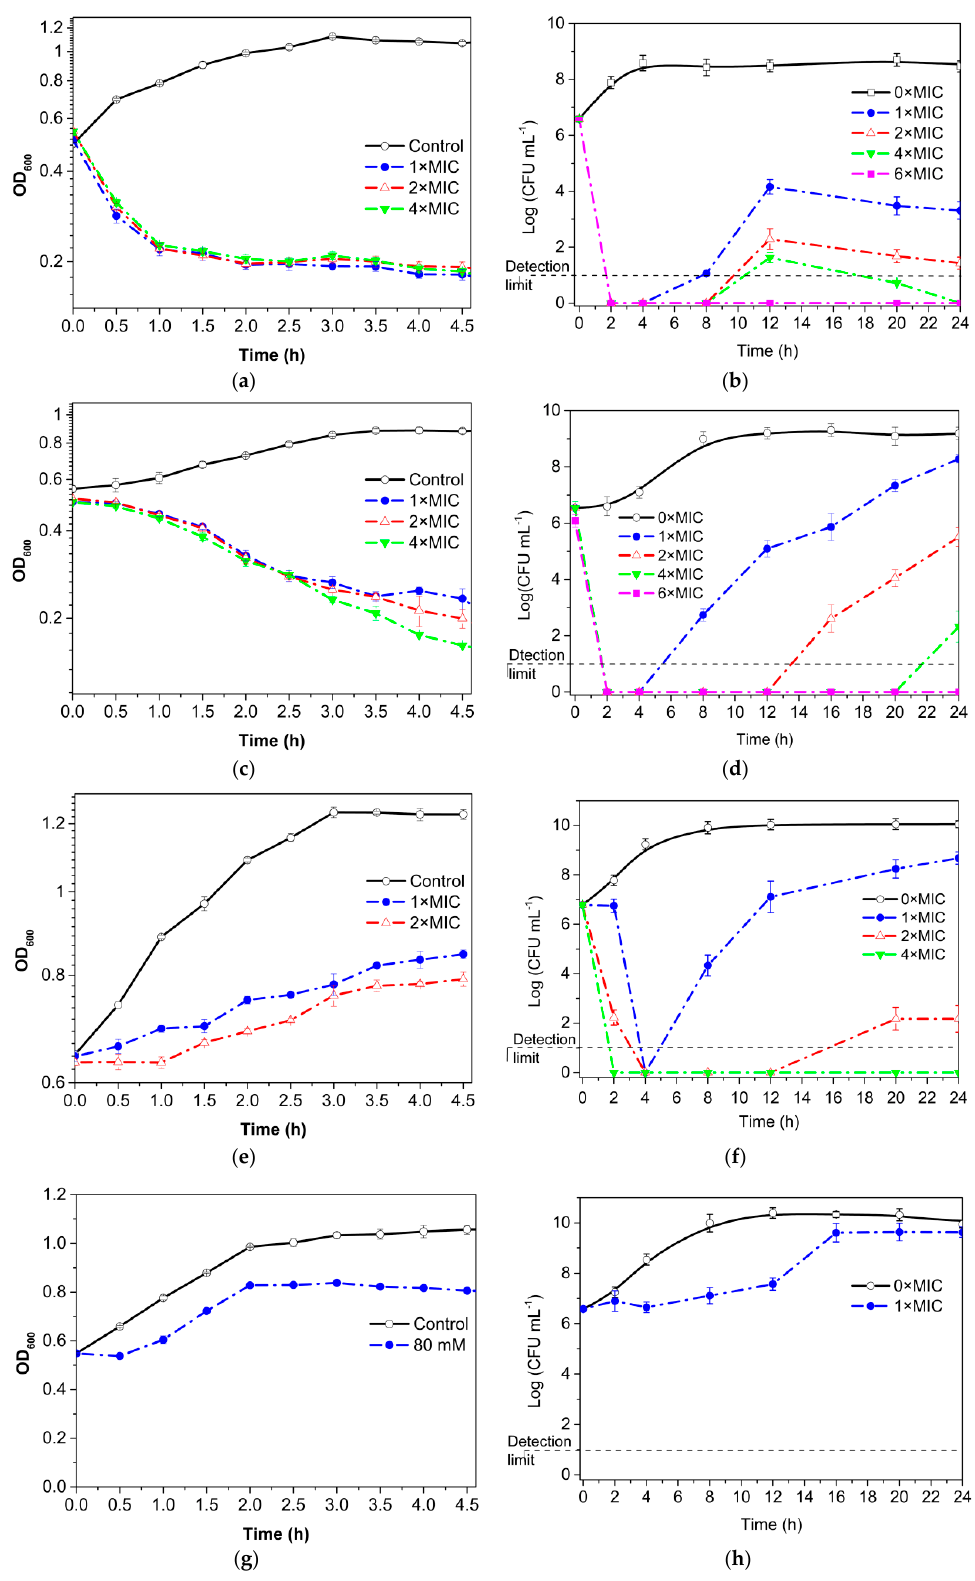
Figure 1. Time–kill curves of SML at the different concentration against various microorganisms. ( a , b ) L. monocytogenes ; ( c , d ) B. subtilis ; ( e , f ) S. aureus ; ( g , h ) E. coli. The error bars represent the standard deviations.